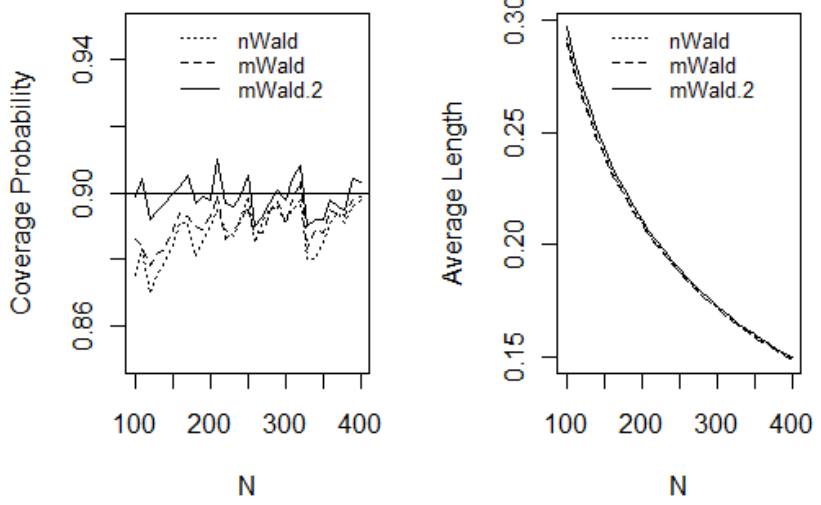
Figure 1. Coverage probabilities and average lengths versus total sample sizes N where ( p 1 , p 2 ) = (0.4, 0.6). The false positive rate is φ = 0.1 and the ratio of substudy sample size versus the total sample size s = n/N = 0.2.